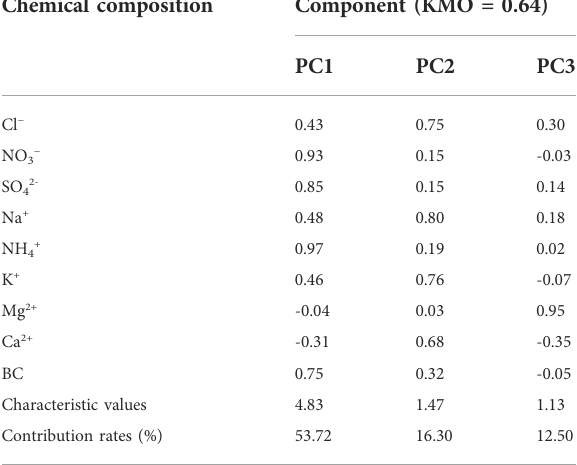
TABLE 2 Rotated component matrix of the principal component analysis during the measurement